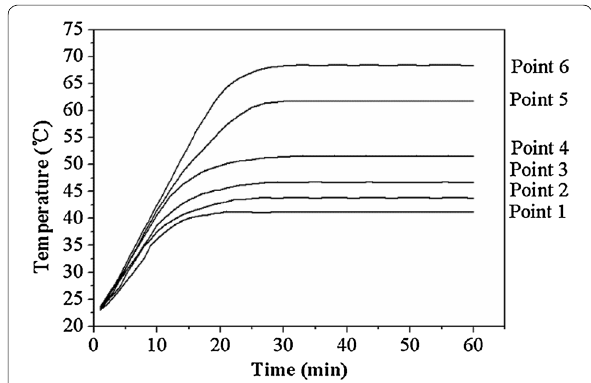
Figure 15 Changing curve of output temperature when copper disk’s thermal loss is 50